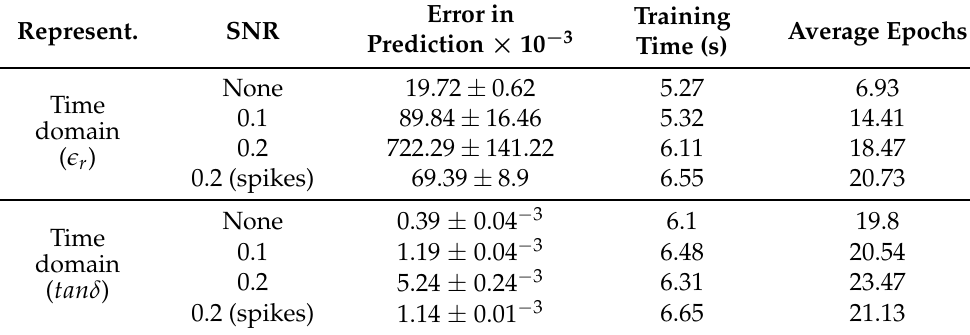
Table 4. Estimation of (cid:101) r , tan δ with different noise levels added. Represent. SNR